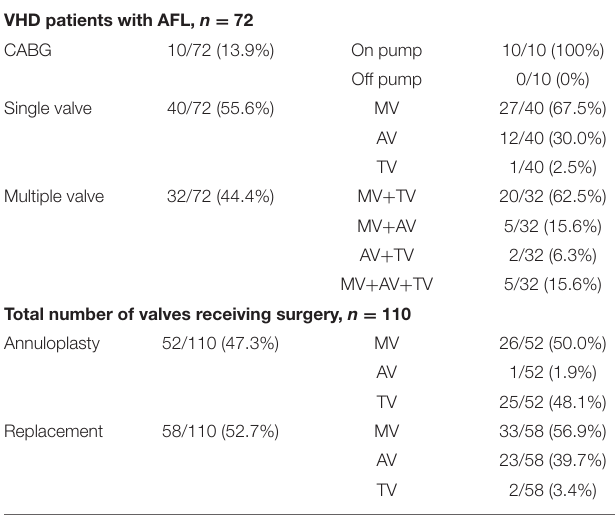
TABLE 5 | Surgical detail in our study population. VHD patients with AFL, n = 72 CABG